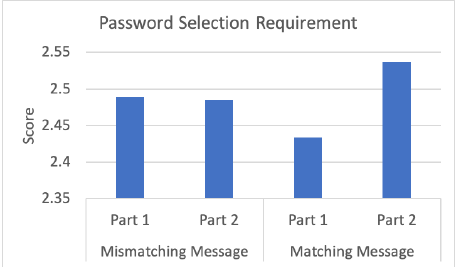
Figure 12. Password Selection Requirement Scores